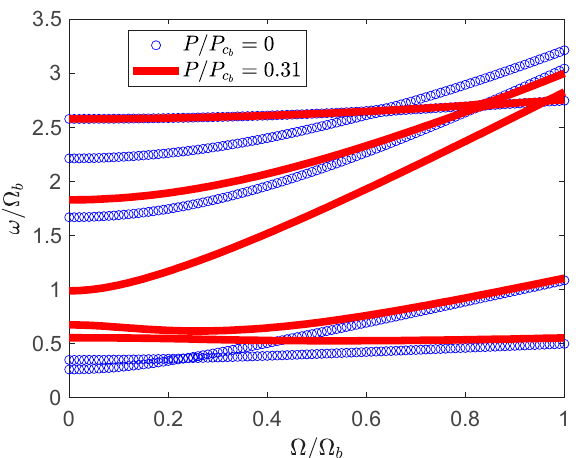
Figure 9. The effect of compressive force on the frequencies of the blade after the first instability point ( P/P c = 0.31) and for θ = 20 ◦ .